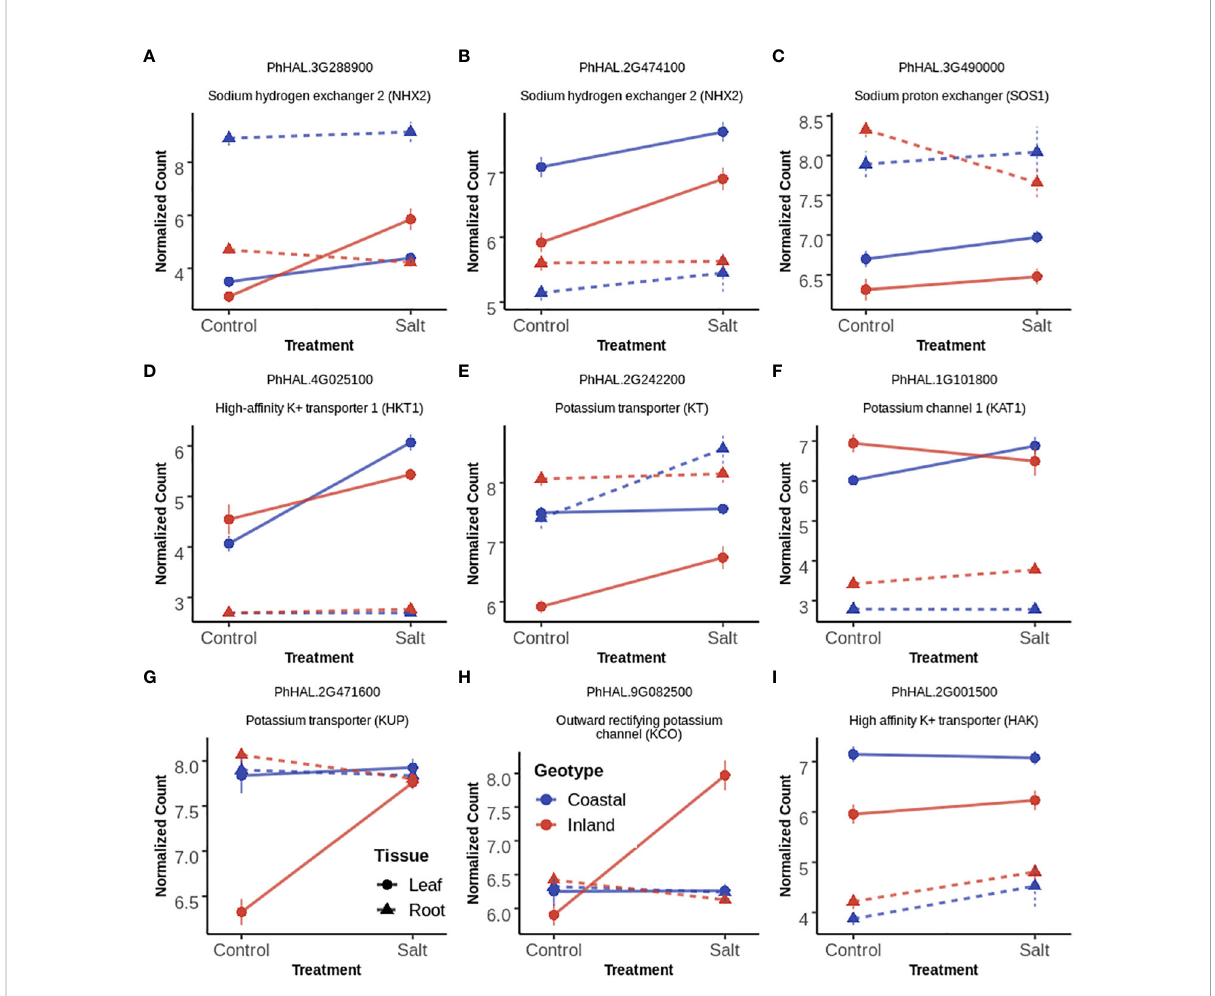
FIGURE 5 Gene expression pro fi le of selected ion transporters ( A – I panels) in leaf and root tissues with Treatment (T), both Genotype and Treatment (G+T) and Genotype by Treatment (GxT) interaction effects. In each panel, each point and error bar represent the mean and 1 SE of normalized gene expression of a selected gene for a given genotype, treatment and tissue level. Normalization was carried out by Variance Stabilizing Transformation (VST). Lines represent the change of gene expression for a given tissue and genotype in response to salinity while the color of lines represent the genotypes. Types of line represents tissue type (solid=leaf tissue; dotted=root